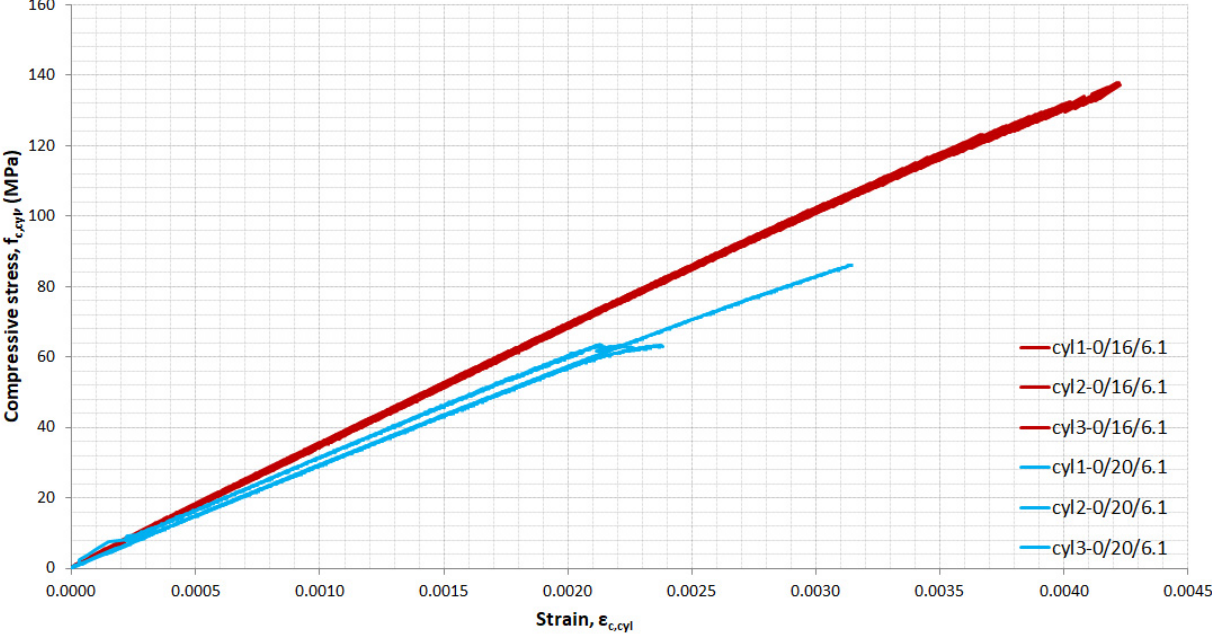
Figure 9. Stress–strain curves in compression for UHPC: The influence of w/b .